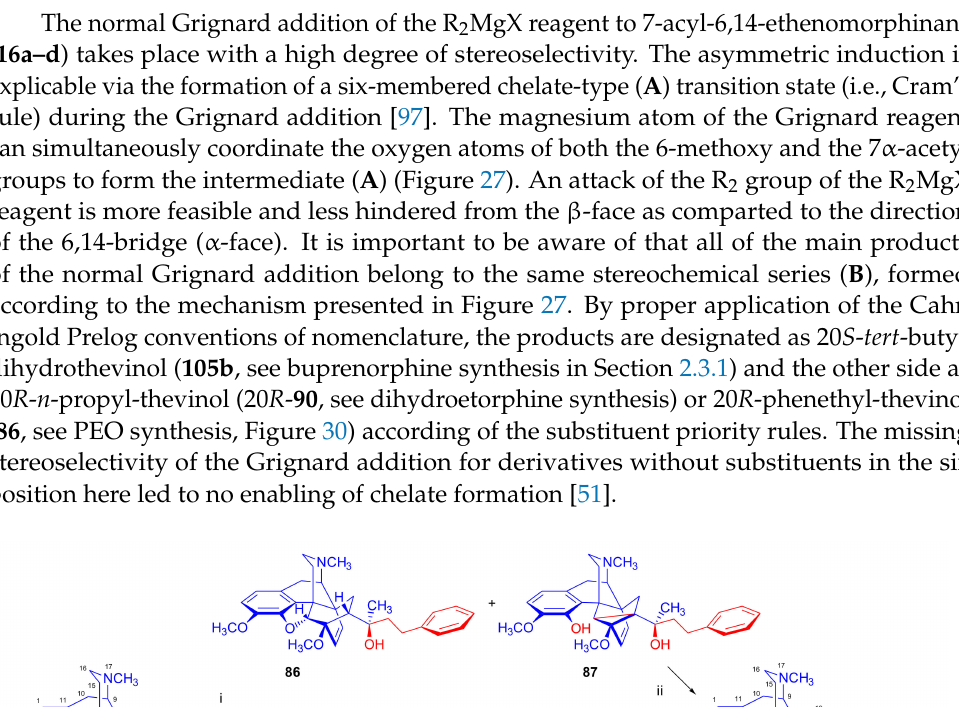
Figure 29. Base-catalyzed rearrangement in the reaction of thevinone ( 16a ) with 2- phenethylmagnesium bromide.